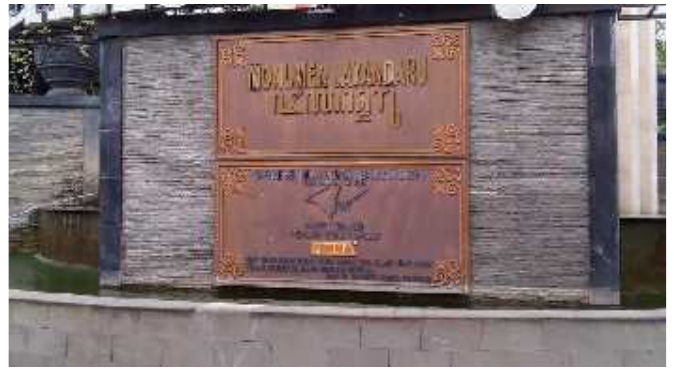
Figure 7. Monumen